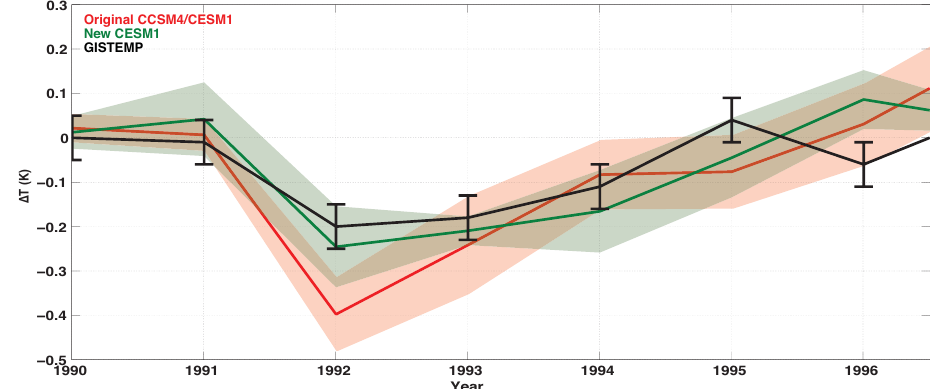
Figure 5. Global, annual, ensemble, and mean temperature anomaly due to the observed (GISTEMP) and simulated Mt. Pinatubo eruption in June of 1991. Anomalies are referenced to the 1990 annual mean in each ensemble member. Shaded regions represent the ± 1 σ standard deviation of the ensemble. Error bars on the observed record come from Hansen et al. (2010) and the GISTEMP Team (2015) estimates.